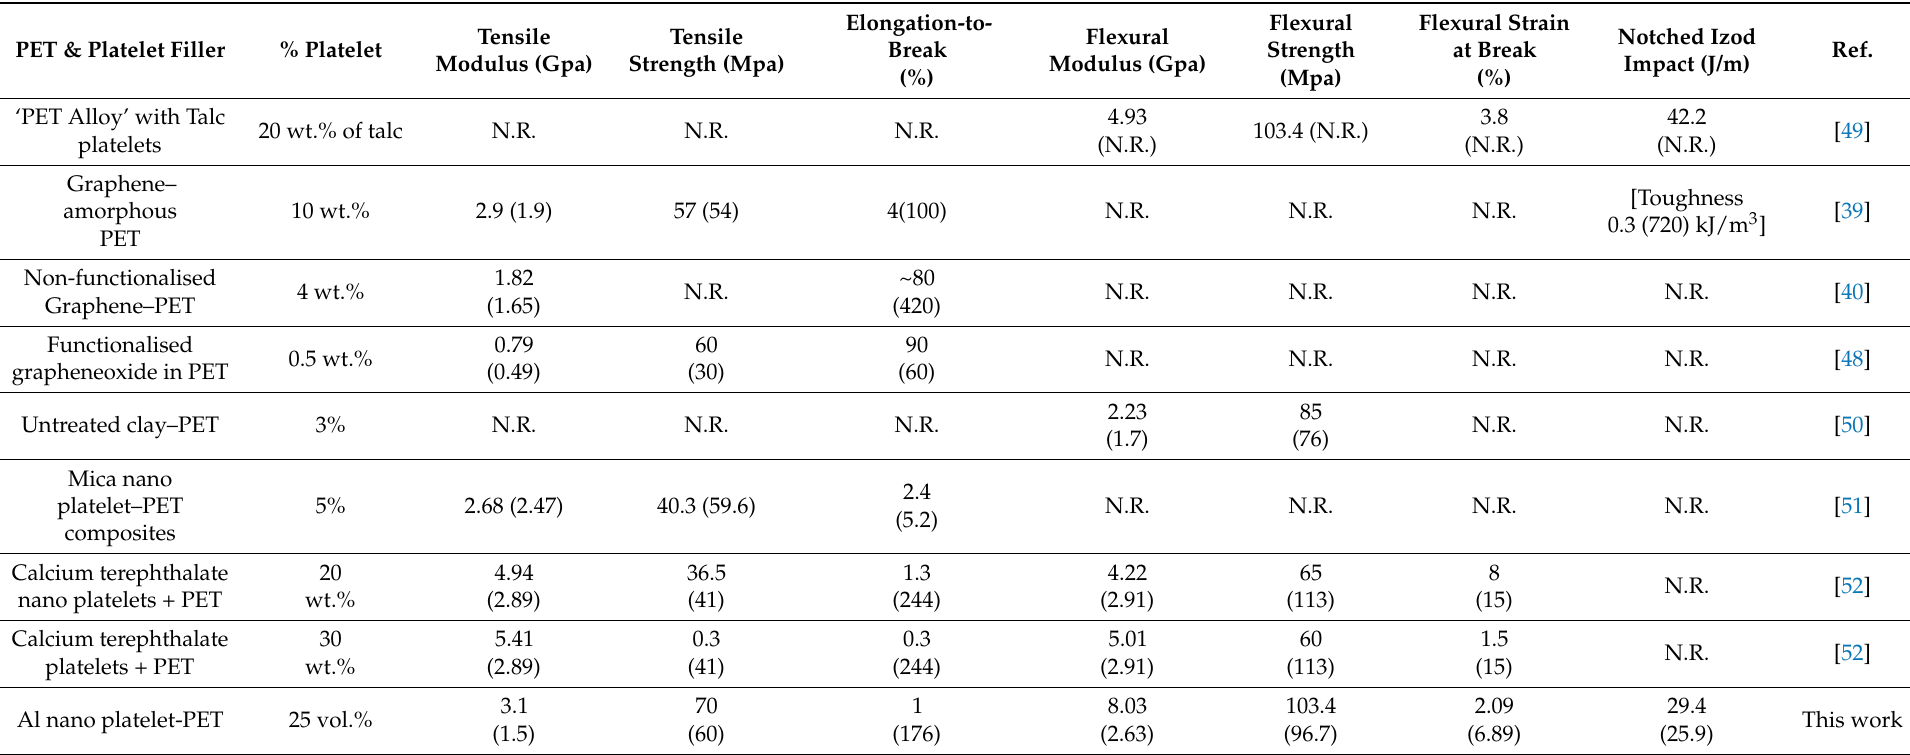
Table 4. Mechanical properties of PET with various nano platelet fillers. The values in brackets are those of the control material (unfilled PET) as reported in the respective works. N.R.—Not